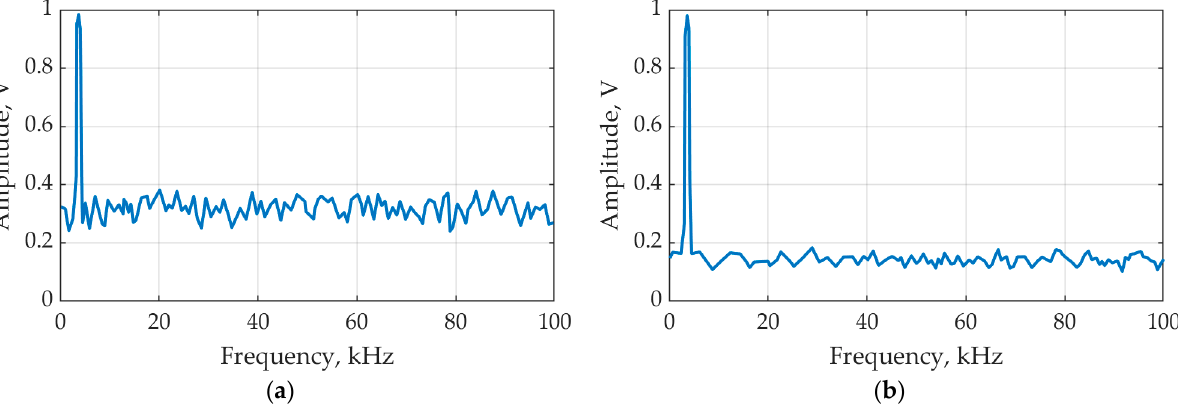
Figure 6. Results of SFCW signals compression: ( a ) compression of non-normalized samples; ( b ) compression of normalized samples.